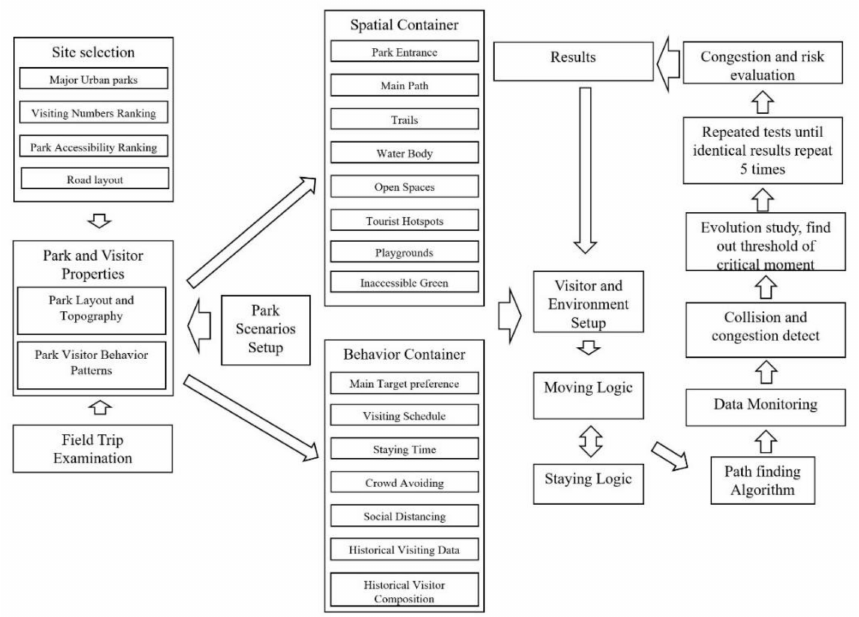
Figure A2. The diagram of workflow. Copyright 2020 © Author, all rights reserved, used by permission.